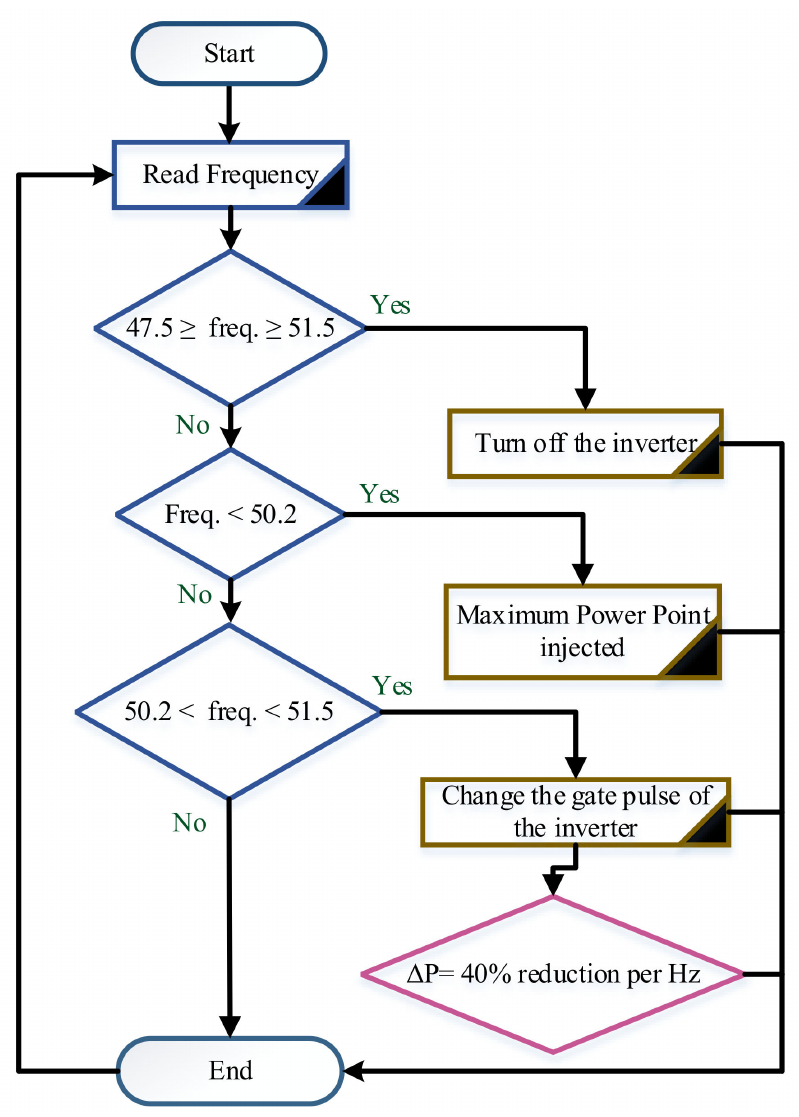
Figure 8. Flowchart algorithm of controller.